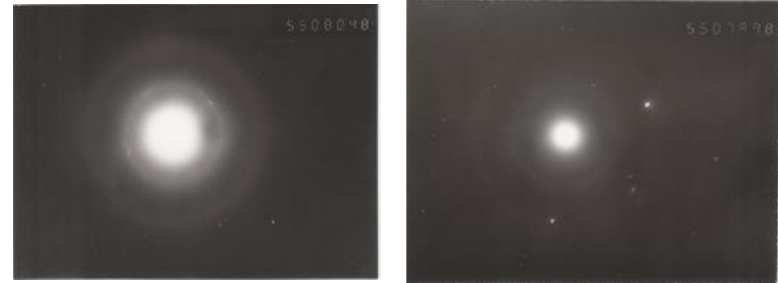
Figure 3. Nanodiamond X-ray diffraction pattern.